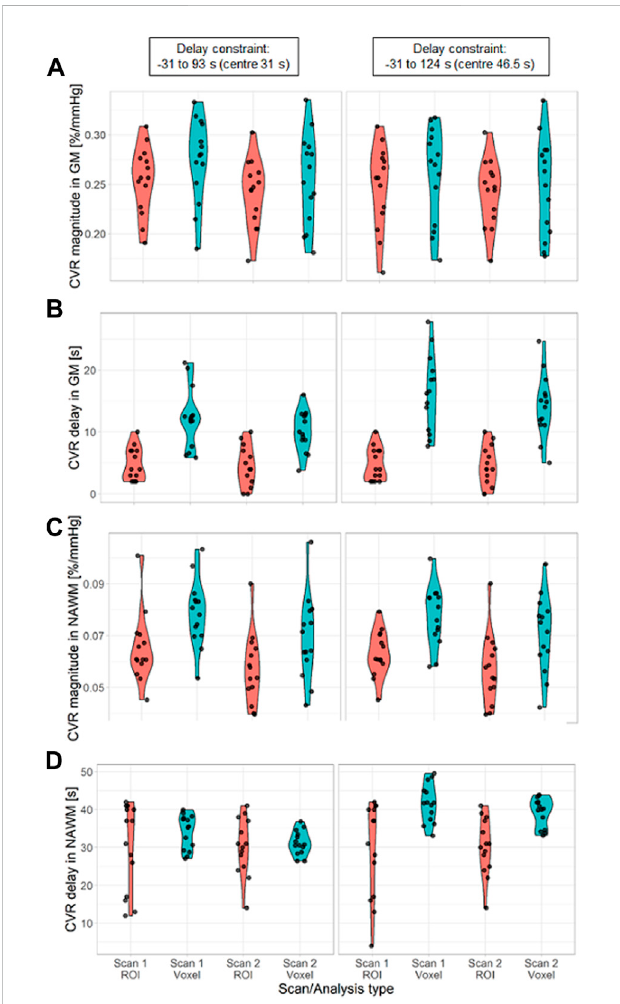
FIGURE 6 Violin distribution of CVR magnitude (A, C) and delay (B, D) in SGM (A, B) and NAWM (C, D) as a function of the scan and the processing method:ROI-based(red)versusvoxel-basedanalysis(blue).Theanalysis was performed with two different delay constraints: − 31 – 93 s ( fi rst column)and − 31 – 124 s(secondcolumn).(SGM,Subcorticalgreymatter; NAWM, Normal-appearing white matter).